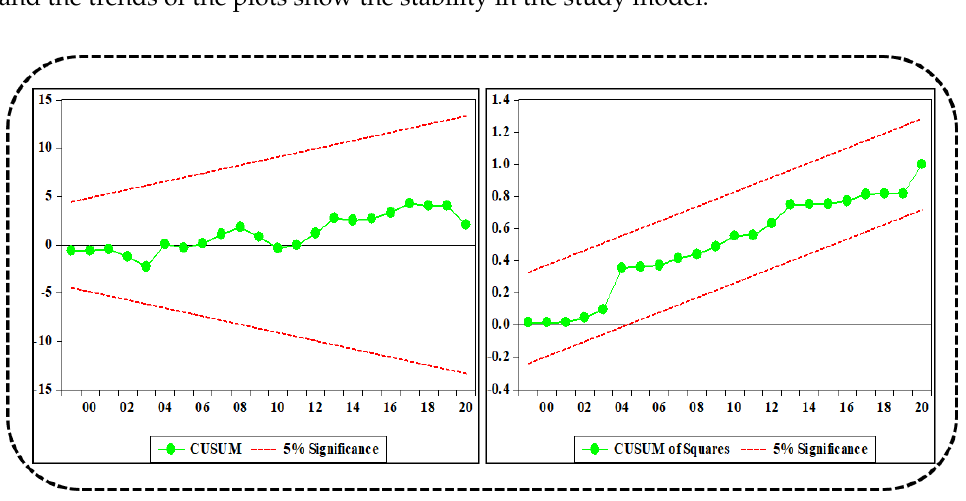
Figure 4. Plot of the CUSUM and its squares.